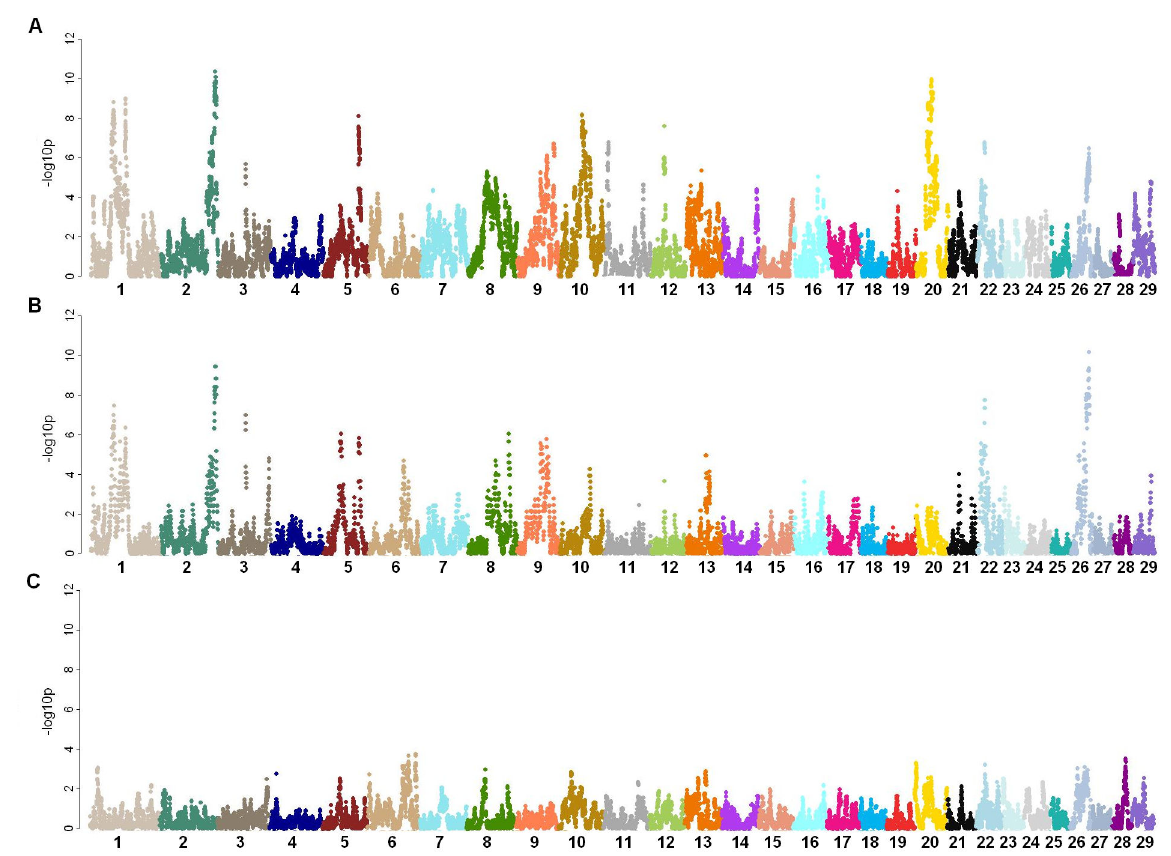
Figure 2. Two way comparisons of F between Groups. Manhattan plots of comparative autozygosity were generated using – L log p of chi-square tests between two groups (y-axis) for each SNP locus relative to its genome coordinate (x-axis; Chr indicated) 10 for A) Group II-A versus I, B) Group II-B versus I, and C) Group II-A versus II-B.